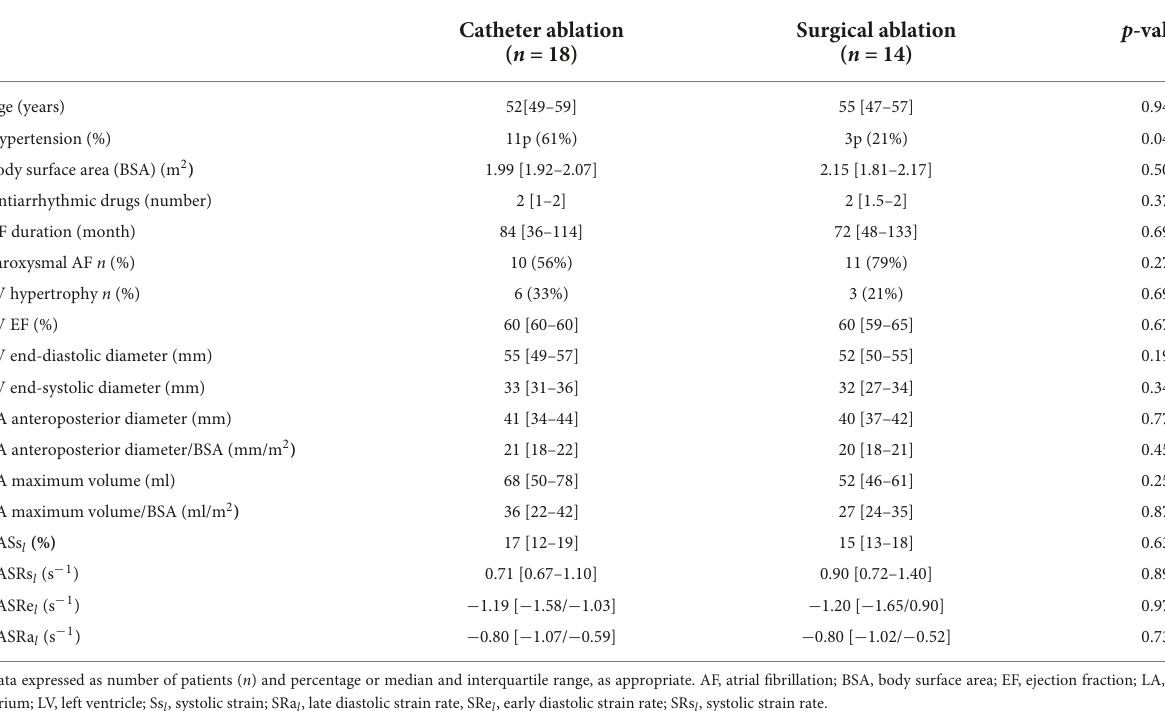
TABLE 1 Baseline clinical and echocardiographic parameters.